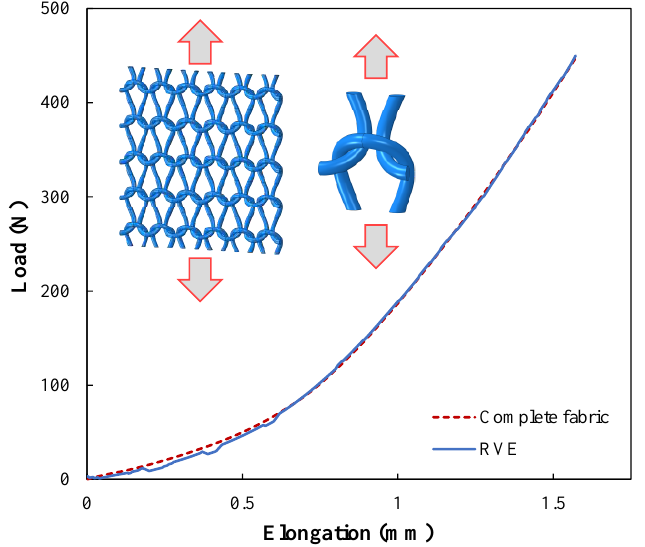
Figure 6. Comparison of the load-elongation curve of the complete fabric model and its RVE under tensile loading in the wale direction.